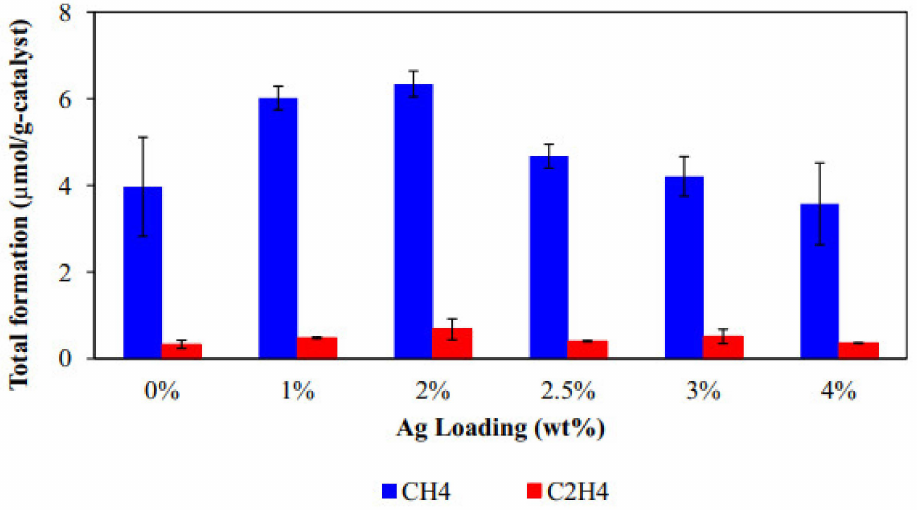
Figure 15. Production of CH 4 and C 2 H 4 over Ag-MWCNT@TiO 2 for various concentrations of Ag. Reprinted with permission from Elsevier, 19 December 2021 Ref.